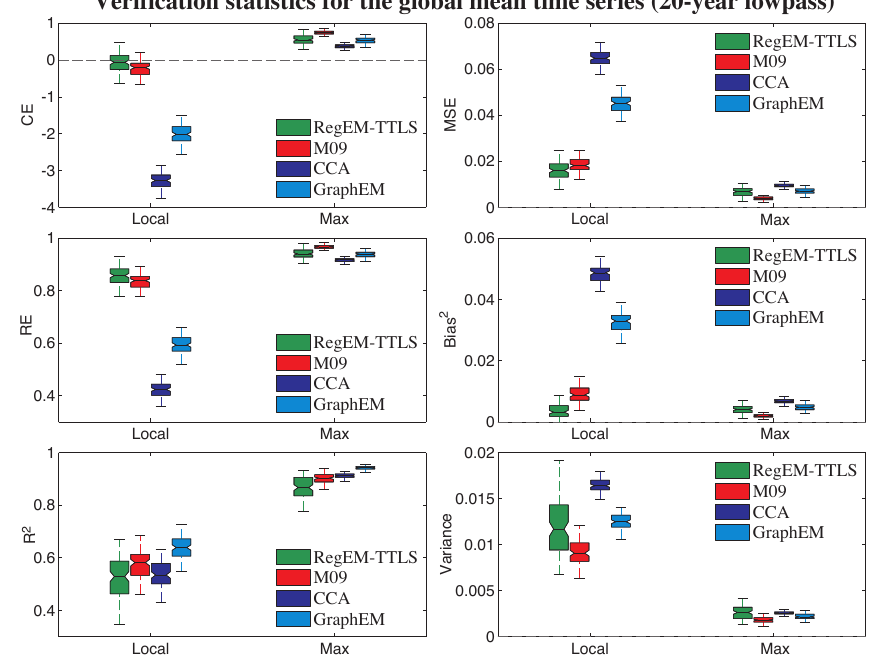
Fig. 6. Summary of verification statistics of the global mean temperature reconstruction ensemble. Note the range of ordinates for each metric is different. MSE=variance + bias 2 .